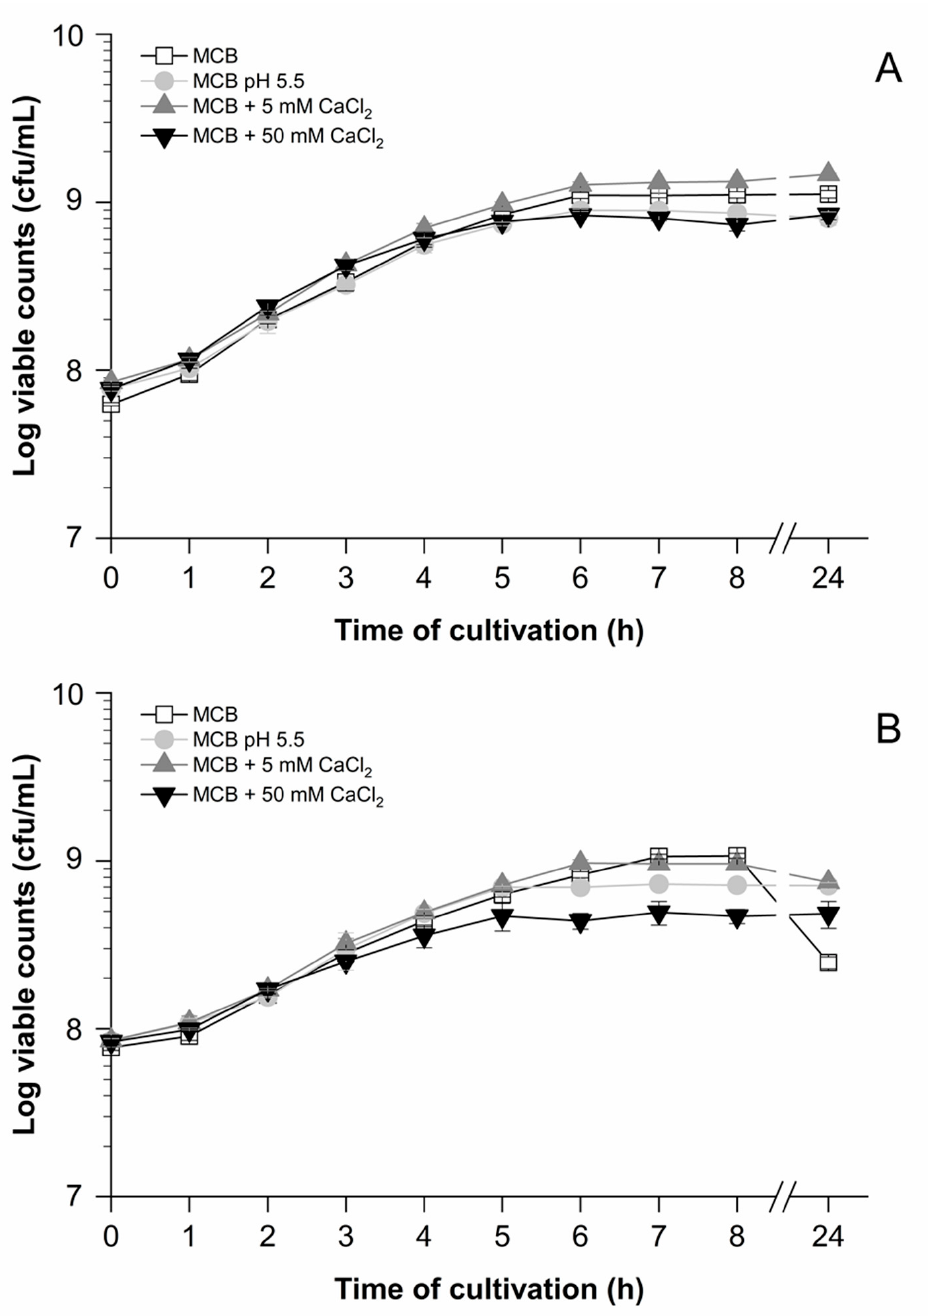
Figure 2. Semilogarithmic graph of growth curves of strains L. lactis LTH 7122 ( A ) and LTH 7123 ( B ) in different compositions of milk citrate broth (MCB). Cultivation was conducted for 24 h in basic MCB (pH 6.6), MCB (pH 5.5), basic MCB plus 5 mM calcium chloride, and basic MCB plus 50 mM calcium chloride at 30 °C without agitation. The viable counts (cfu/mL) were determined hourly. Data represent mean values and standard deviations from biological and technical duplicates.